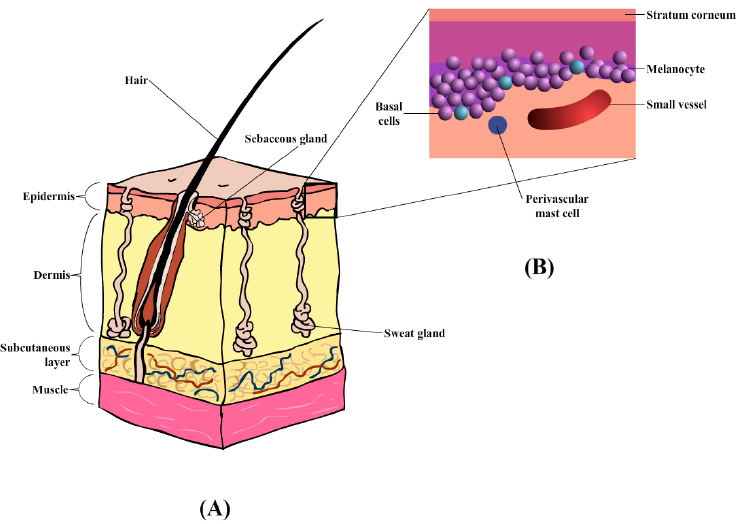
Figure 3. ( A ) Diagrammatic illustration of horse skin, containing three main layers: epidermis, dermis, and subcutaneous layers, together with hair follicles and sweat glands. ( B ) Enlarged illustration of the epidermis layer, containing the stratum corneum, melanocyte, basal, and perivascular mast cells.